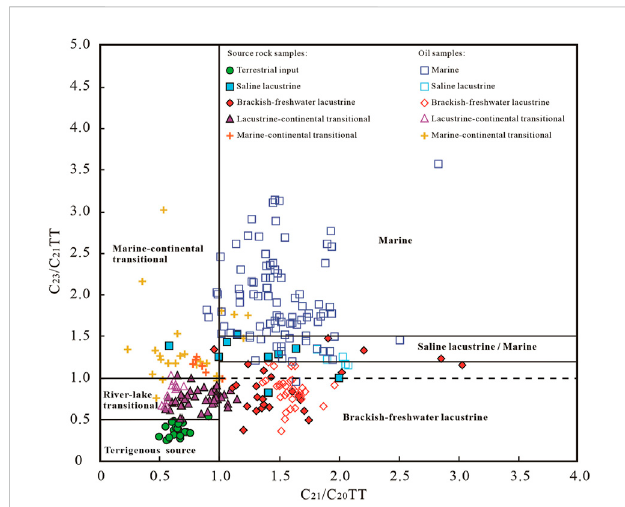
Cross-plots of C 20 -C 21 -C 23 tricyclic terpane (TT) ratios in context of depositional environments. The solid boundary lines were established with con fi dence by the data. The dotted line is a speculated boundary between brackish and freshwater lacustrine